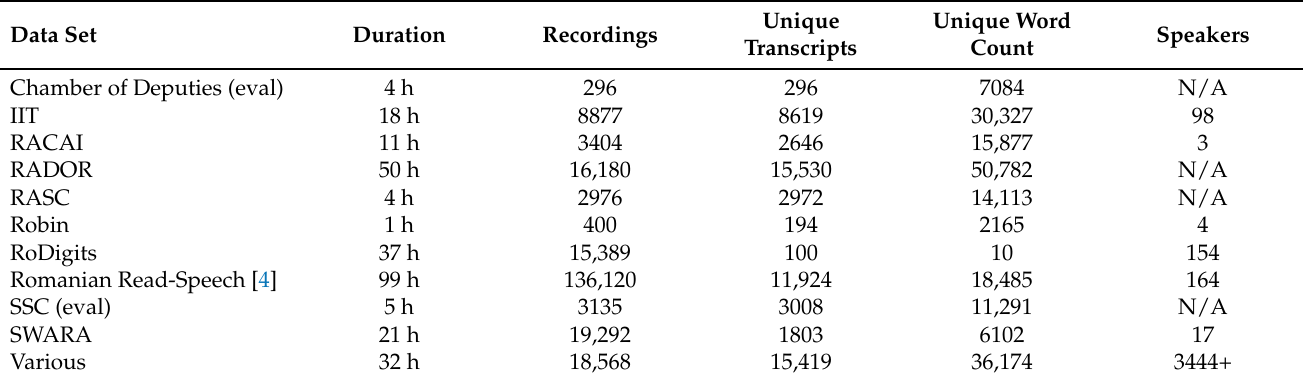
Table 1. Available speech datasets for the Romanian